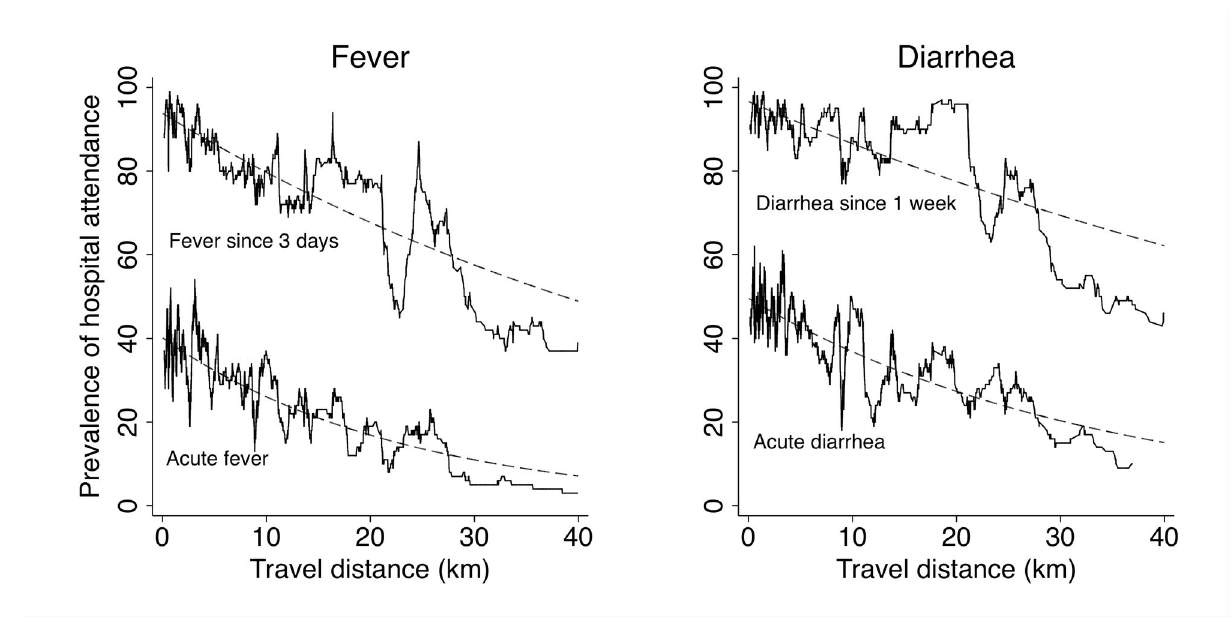
Figure 1. Observed prevalence (solid line) and predicted prevalence (dashed line) of intended hospital attendance by symptom along the travel distance to the nearest hospitals, Asante Akim North District, Ghana, 2008. doi: